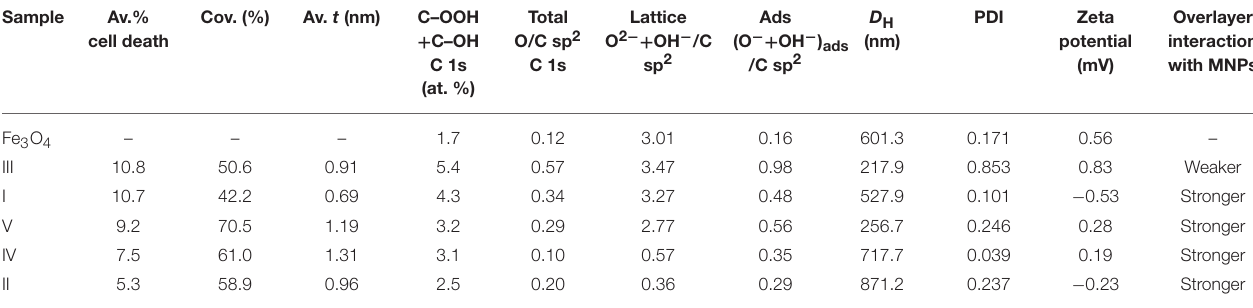
TABLE 4 | Dependence of cytotoxicity tested for HeLa cells on surface properties of Fe 3 O 4 f-MNPs I–V.